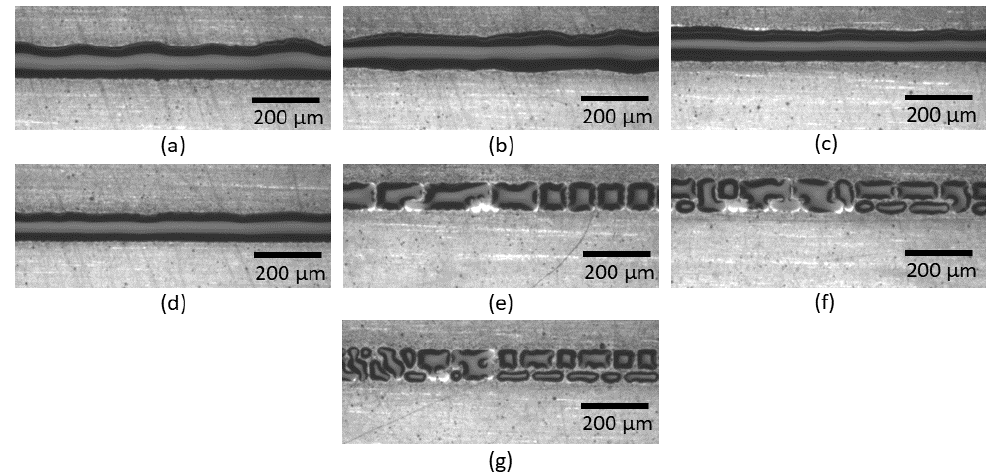
Figure 3. Single Line Tests at Different Drop Spacing Values: ( a ) Drop Spacing of 30 µ m, ( b ) Drop Spacing of 35 µ m, ( c ) Drop Spacing of 40 µ m, ( d ) Drop Spacing of 45 µ m, ( e ) Drop Spacing of 50 µ m, ( f ) Drop Spacing of 55 µ m, ( g ) Drop Spacing of 60 µ m